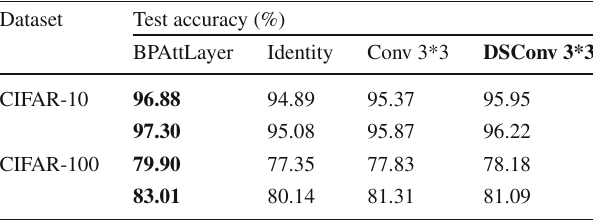
Table 5 The results of the ablation experiment on BPAttLayer. Each row denotes the result of the same dataset, and each column represents the result of replacing BPAttLayer in AEMONet-A and AEMONet-B Dataset